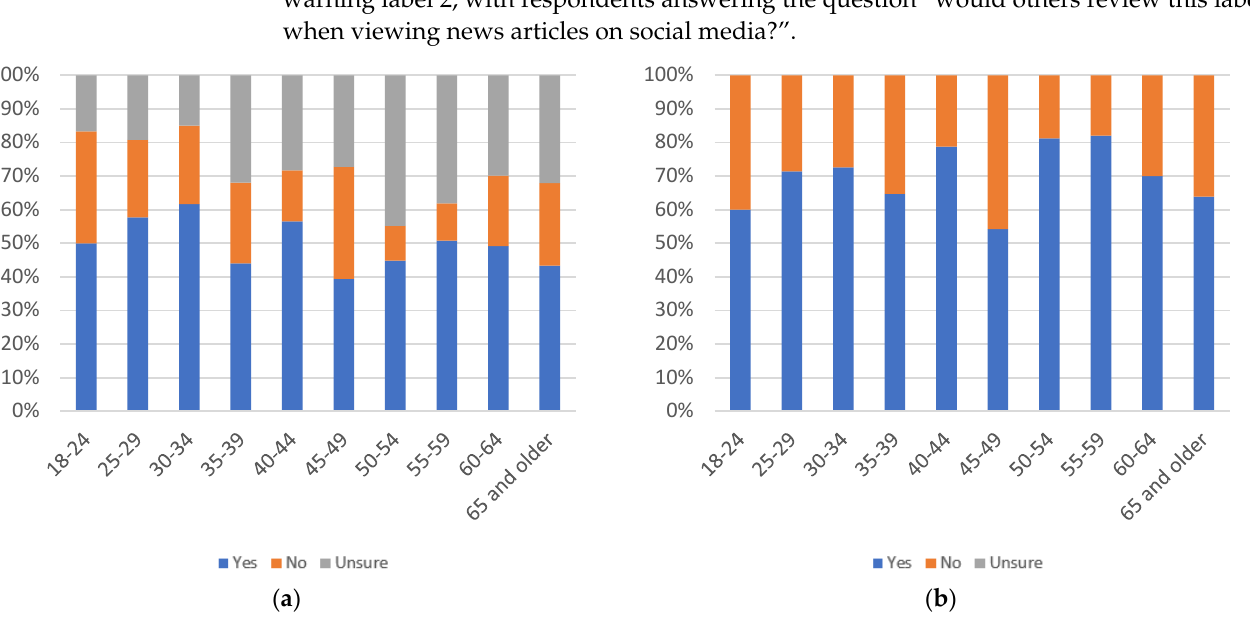
( b ) Figure 79. Label others’ use, by education level: ( a ) with uncertain respondents (left) and ( b ) without uncertain respondents (right).